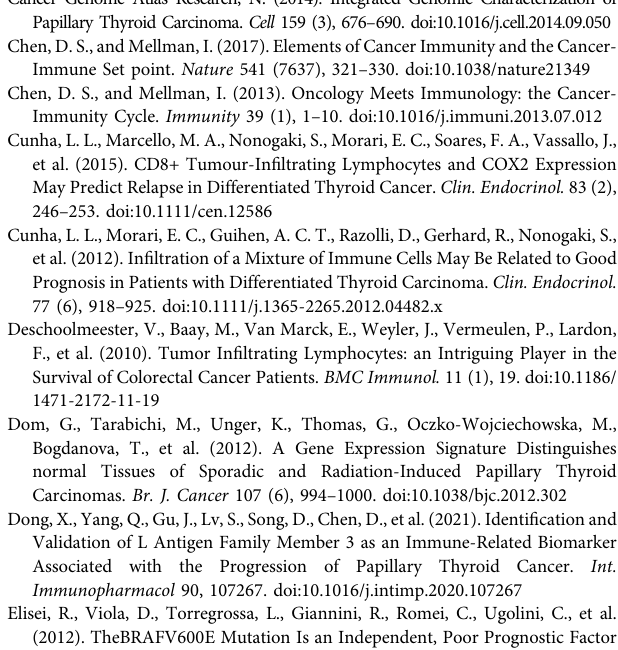
Supplementary Figure 1 | Identi fi cation of MVP as an important BRAF -driven oncogene in PTC. (A) t-SNE analysis of the TCGA cohort. (B) Volcano plot of differentially expressed genes between BVL and RL PTCs. (C) Heatmap of top 20 differentially expressed genes between BVL and RL PTCs. Supplementary Figure 2 | Association of MVP level with BRAFV600E and prognosis in WMU-PTC patients. (A) MVP level in PTC patients strati fi ed by BRAF V600E status. (B) Survival curves comparing patients with distinct MVP expression for progression-free